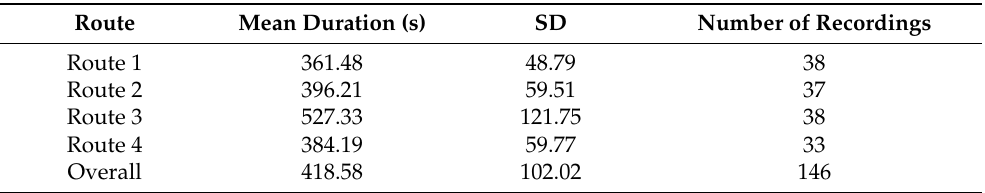
Table 1. Mean durations and number of recordings in each route. Route Mean Duration (s)